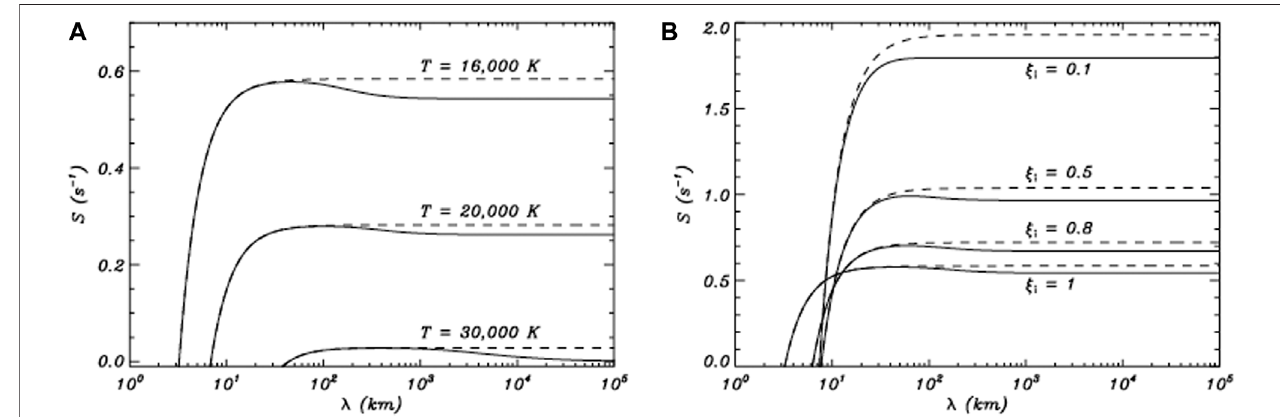
FIGURE 10 | (A) Numerically computed thermal instability growth rate (solid) and approximate value (dashed) vs wavelength for the CHIANTI-based loss function and differentvaluesofthetemperature inthecase ofafullyionizedplasma,i.e., ξ i (cid:1) 1. (B) Same aspanela)for T (cid:1) 16,000 Kbut inthepartiallyionized casewith different values of ξ i . Credit: Soler et al. (2012a), A&A 540, A7, reproduced with permission ©